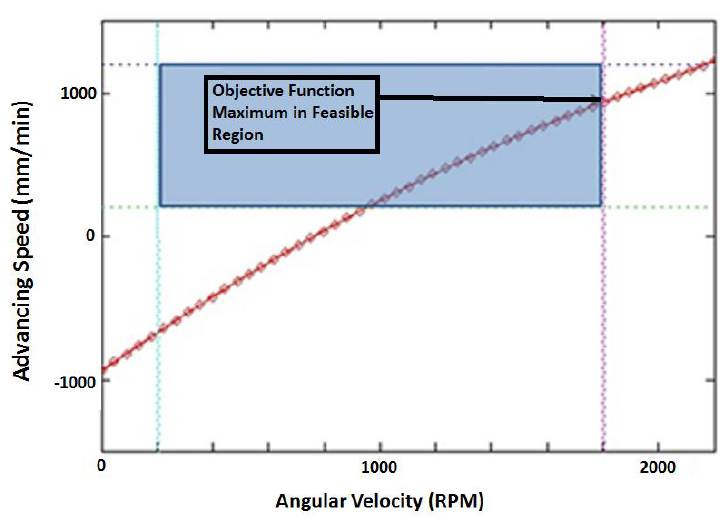
Figure 8. Feasible region.